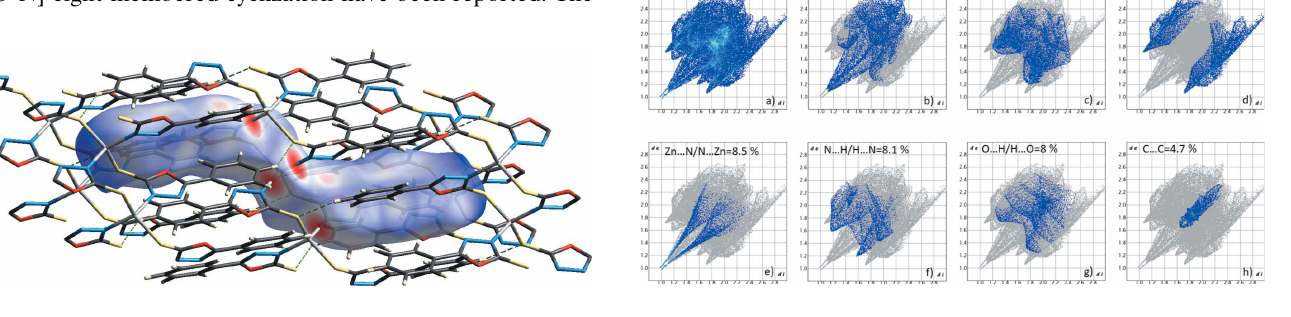
Figure 4 Hirshfeld surfaces mapped over d norm calculated for the monomer part of the polymer molecule.